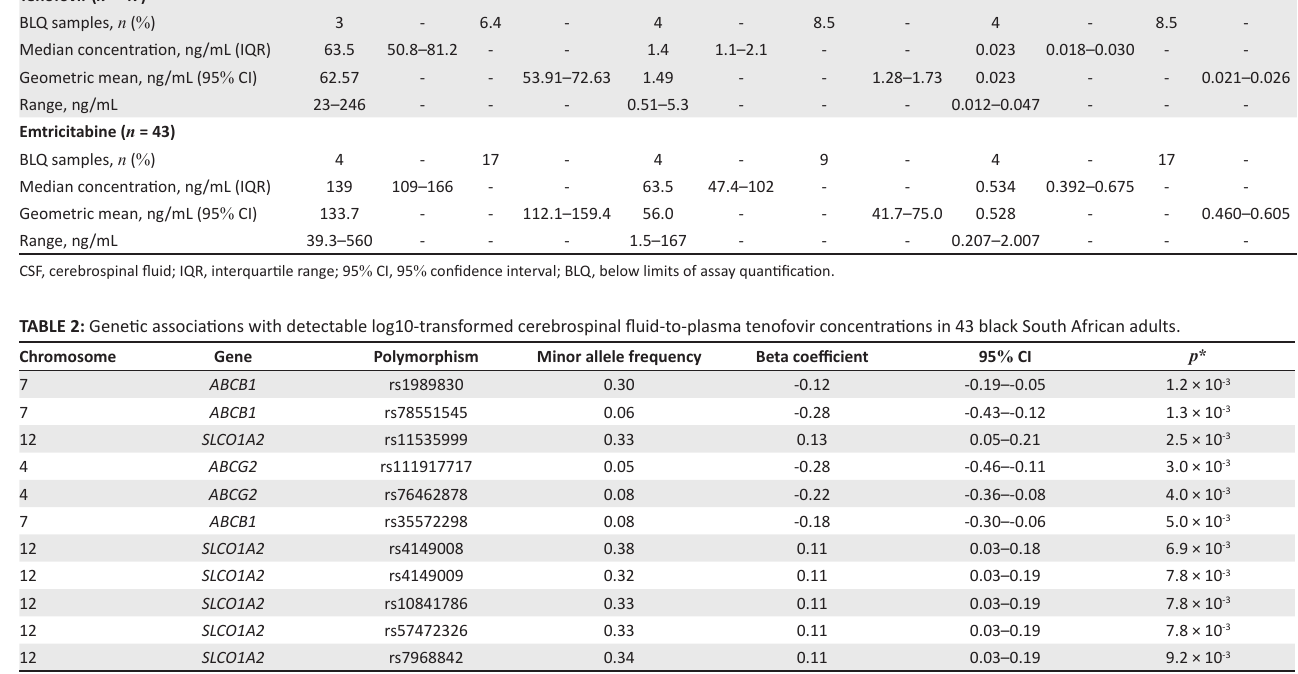
Tenofovir ( n = 47) BLQ samples, n ( %